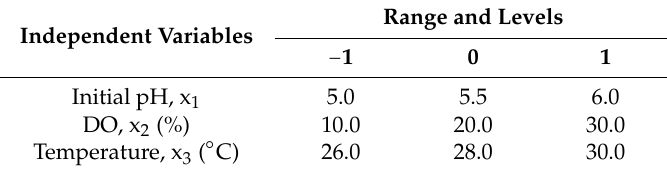
Table 3. The Box-Benhnken design matrix and the mycelial TA responses of G. lingzhi .